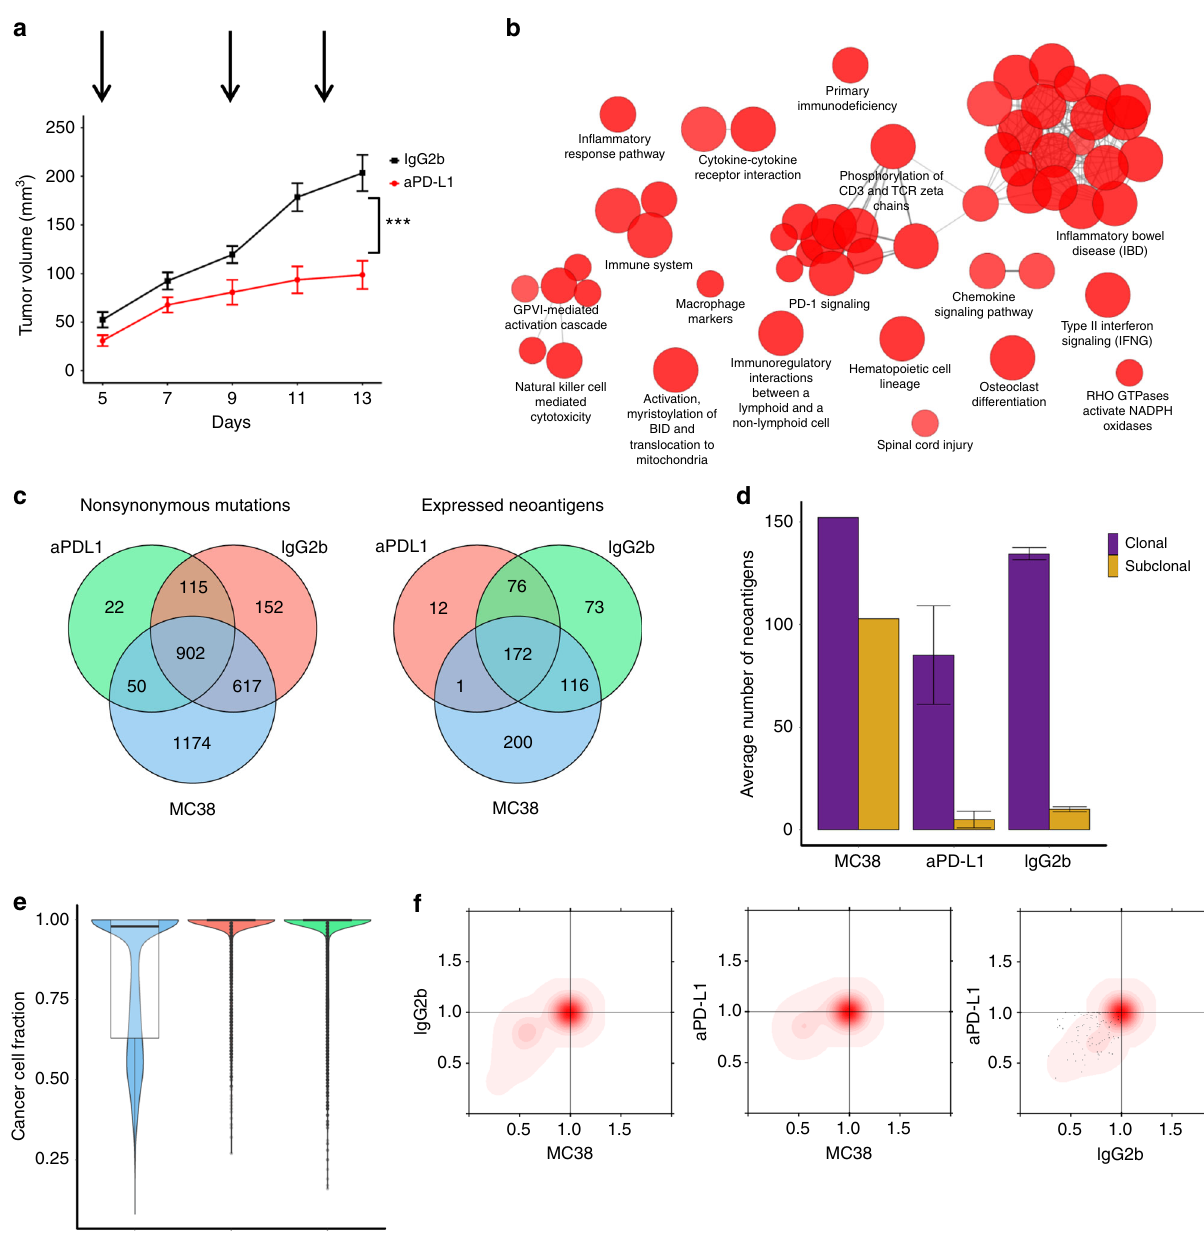
Fig. 4 Genomic and immunogenomic impact of targeting the PD-1/PD-L1 axis. a Tumor growth curve in C57Bl/6 wild-type mice ( n = 11) inoculated with 5 × 10 5 MC38 cells and administered with 0.5 mg of an anti-mouse PD-L1 blocking antibody as immune checkpoint inhibitor is compared with tumor growth curve seen in mice ( n = 12) injected with IgG2b control. The data are expressed as the mean ± SEM, analyzed by a two-tailed unpaired Student ’ s t- test. Statistical signi fi cance is indicated as * p < 0.05, ** p < 0.01, *** p < 0.001. b Enriched functions and pathways of the signi fi cantly differentially expressed genes in tumors of the anti-PD-L1 therapy vs the IgG2b control samples. The network is created using ClueGO. The pathways are functionally grouped based on the kappa score and the most signi fi cant term of each group is highlighted. The size of the nodes shows the enrichment signi fi cance after Bonferroni correction. c Shared nonsynonymous mutations and expressed neoantigens between MC38, and anti-PD-L1 treated and control samples. Mutations/neoantigens found in at least one sample from the same type are considered. d Number of clonal and subclonal expressed neoantigens in MC38 and all tumor samples. Error bars represent standard error of the mean. e Violin plots showing tumor heterogeneity estimated from the cancer cell fractions. f Two-dimensional density plots showing the clustering of the cancer cell fractions of all mutations shared between two samples; increasing intensity of red indicates the location of a high posterior probability of a mutations are potentially targeted by the immune system L1 pathway induces very strong adaptive, and to a lesser extent following blockade of the PD-1/PD-L1 pathway. A smaller innate, -mediated antitumor activity in this mouse model. number of mutations were detectable only in the anti-PD-L1- Analysis of the exome-sequencing data showed 902 mutations treated samples and the MC38 cell line (50). Overall, in the anti- that were shared in all samples and 617 mutations that were PD-L1-treated samples the fraction of mutations resulting in detectable in the control sample and in the MC38 cell line, but expressed antigens was similar to the control sample (~25%). The absent from the anti-PD-L1-treated samples (Fig. 4c). These